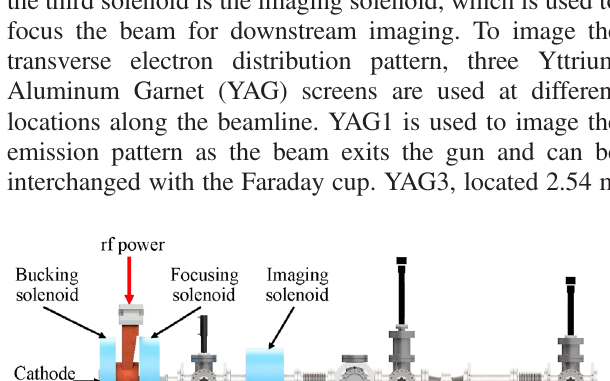
FIG. 3. Comparison of transverse electron patterns (a) as simulated in GPT and (b) as obtained experimentally, both at YAG3 position. The input emitter distribution was generated and imported using a pattern captured in dc, see Fig. 1 in Ref. [24]. Image (b) was processed with FEpic and counted emitters are labeled by red marks. All other images with local maxima identified and labeled as emitters can be found in the FIG. 2. Schematic of the ACT beamline.